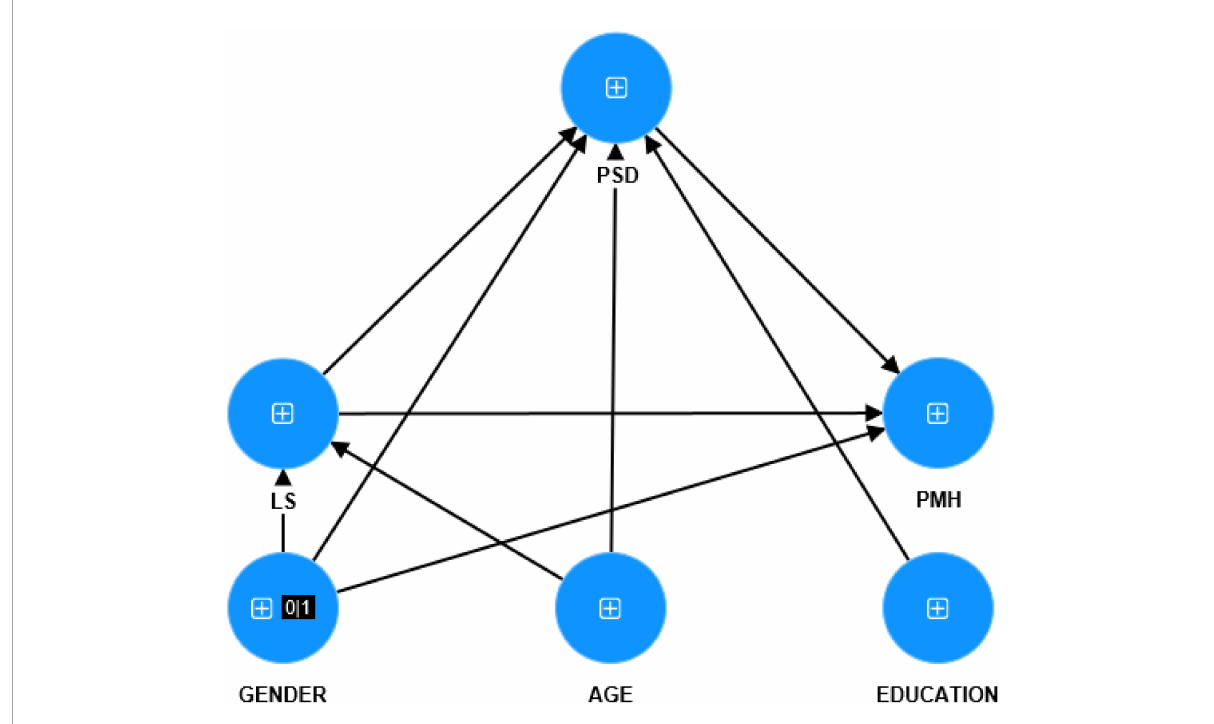
FIGURE1 Hypothetical model. LS, life satisfaction; PSD, post-series depression; PMH, positive mental